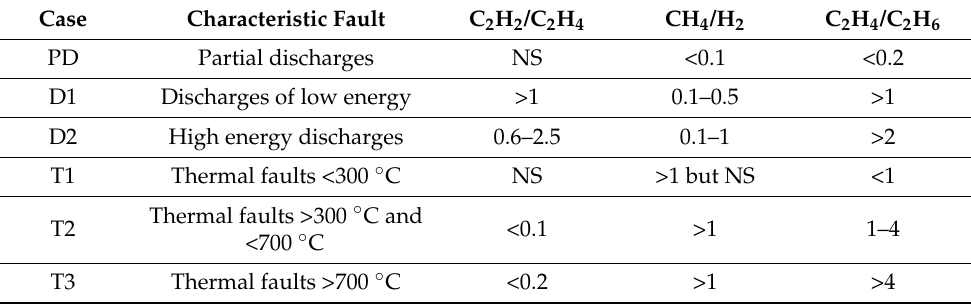
Table 5. IEC ratio